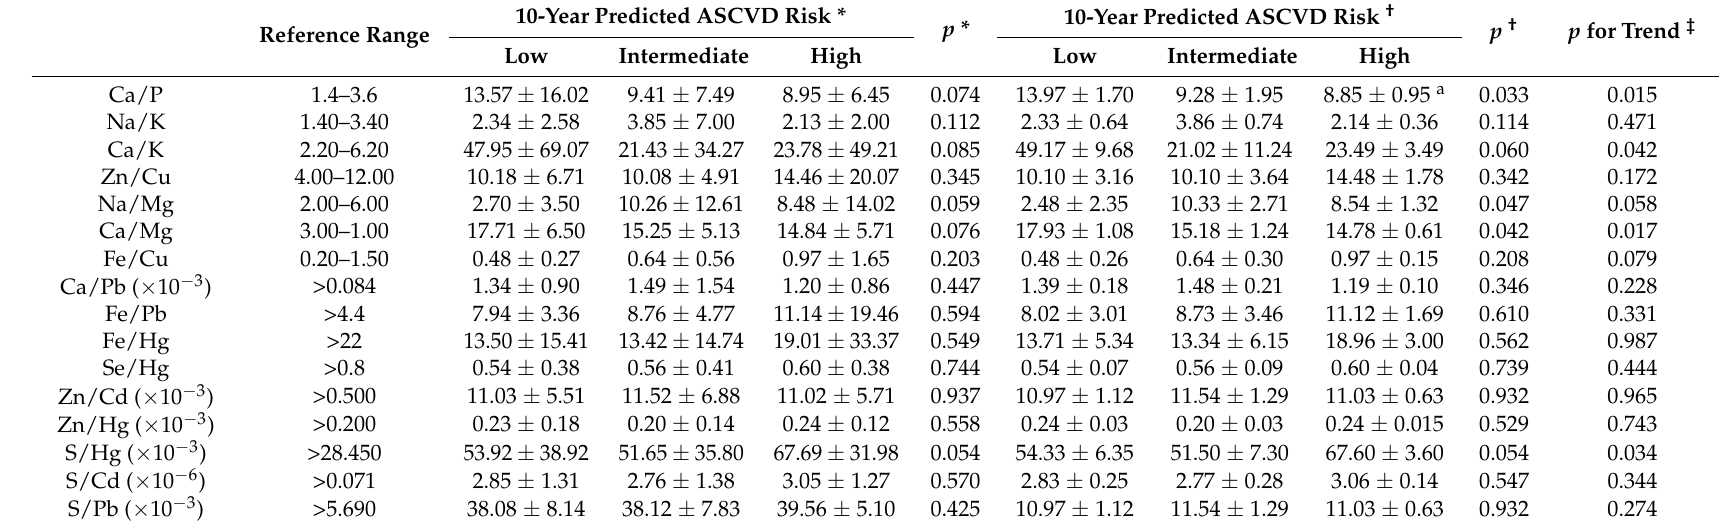
Table 5. Ratios of concentrations of minerals and trace elements in hair of the three groups of subjects stratified by severity of ASCVD risk. Reference